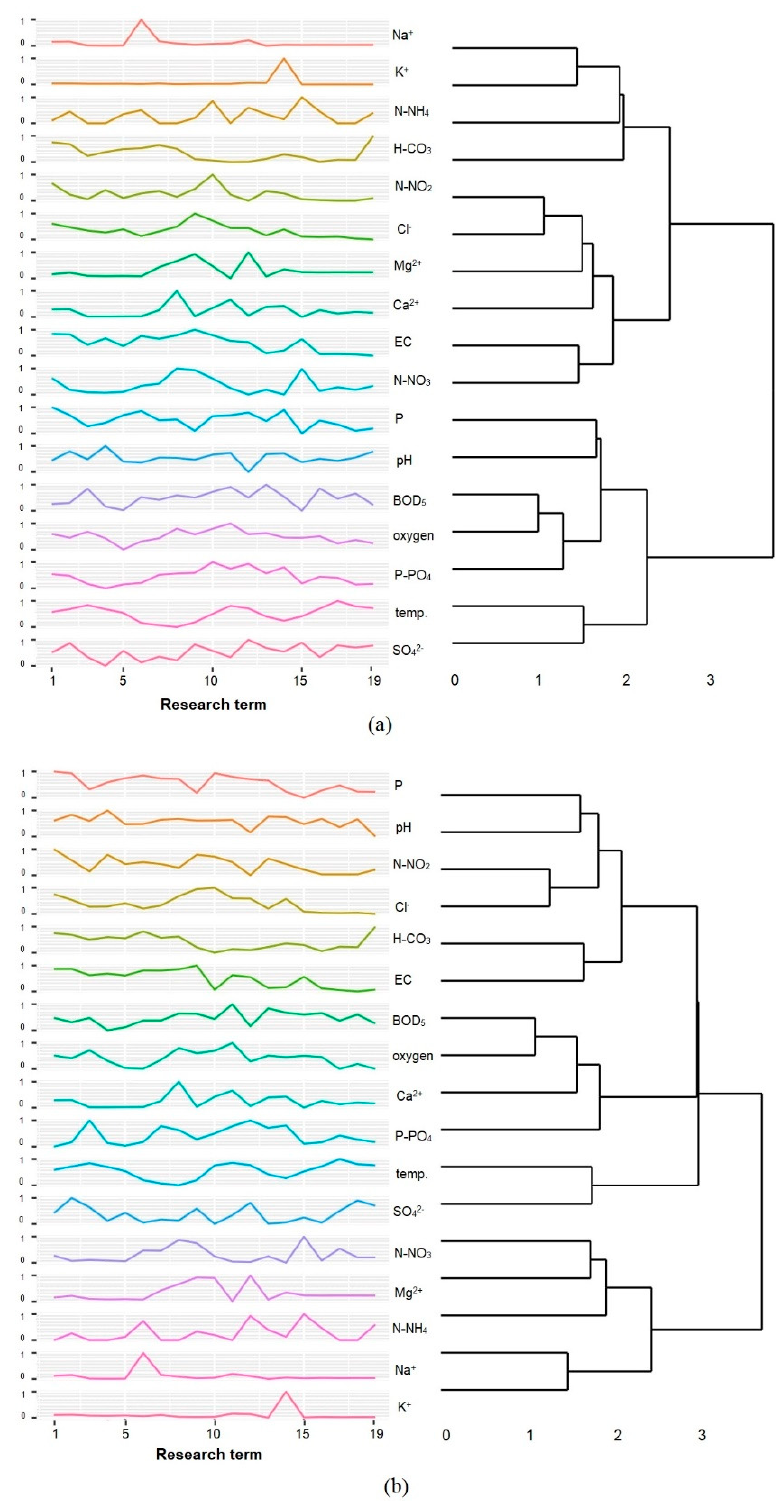
Figure 4. Clustering time series for Lake Kórnickie at SPs JK1 ( a ) and JK2 ( b ).